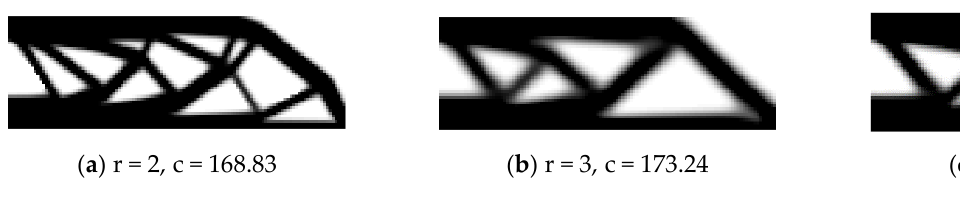
Figure 11. Optimization results of the SIMP-GA method.